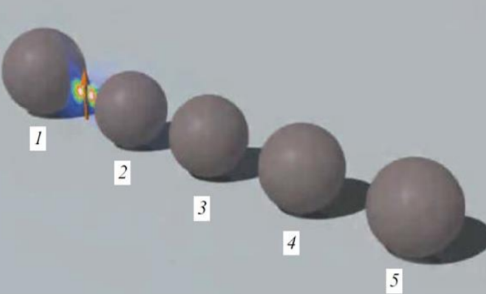
Figure 4. 3D view of an all-dielectric optical Yagi–Uda nanoantenna, consisting of the reflector 1 of the radius Rr = 75 nm, and smaller director 2–5 of the radii Rd = 70 nm (adapted from the work in [7]). The dipole source is placed equally from the reflector and the first director surfaces at the distance D. The separation between surfaces of the neighboring directors is also equal to